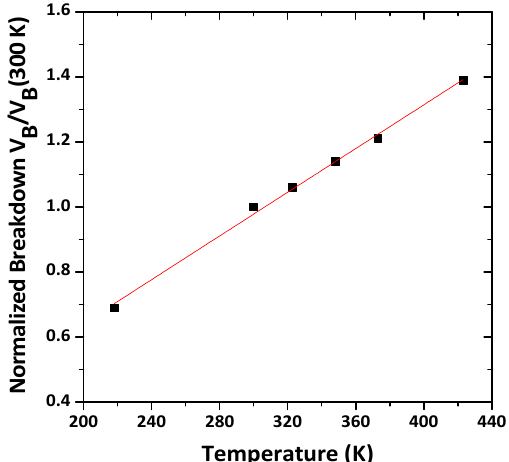
Figure 11. Temperature vs. Normalized Breakdown